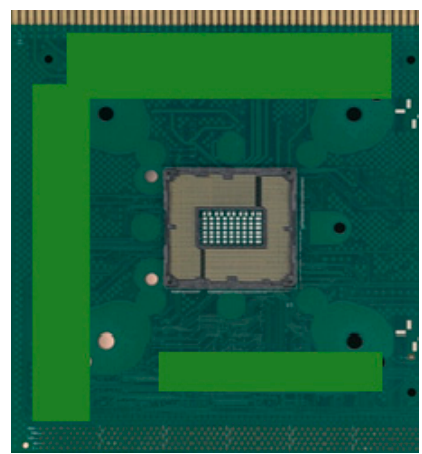
Figure 1. Schematic representation.